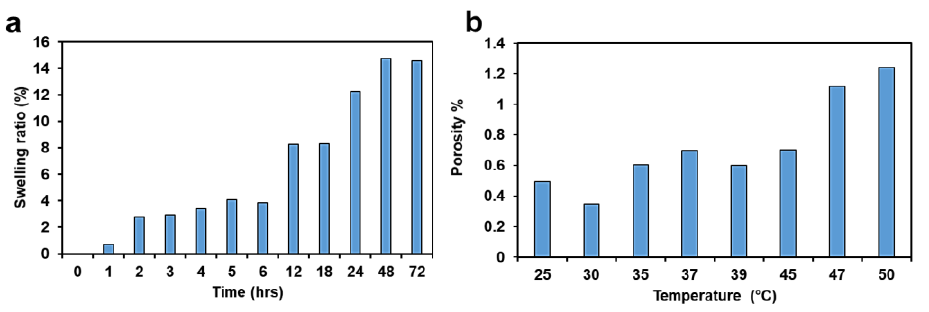
Figure 5. ( a ) Swelling ratio. ( b )